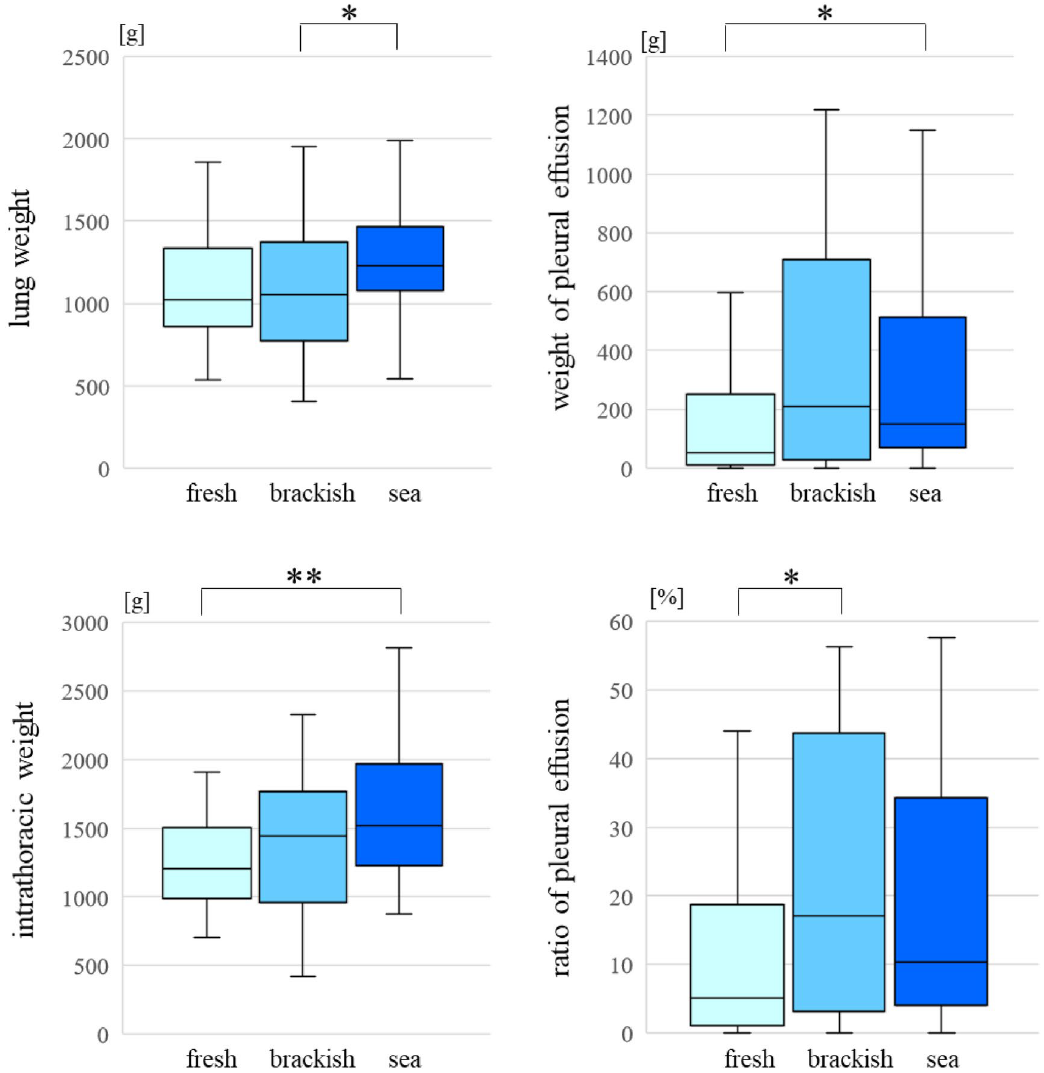
Figure 1. Comparing the parameters for different drowning